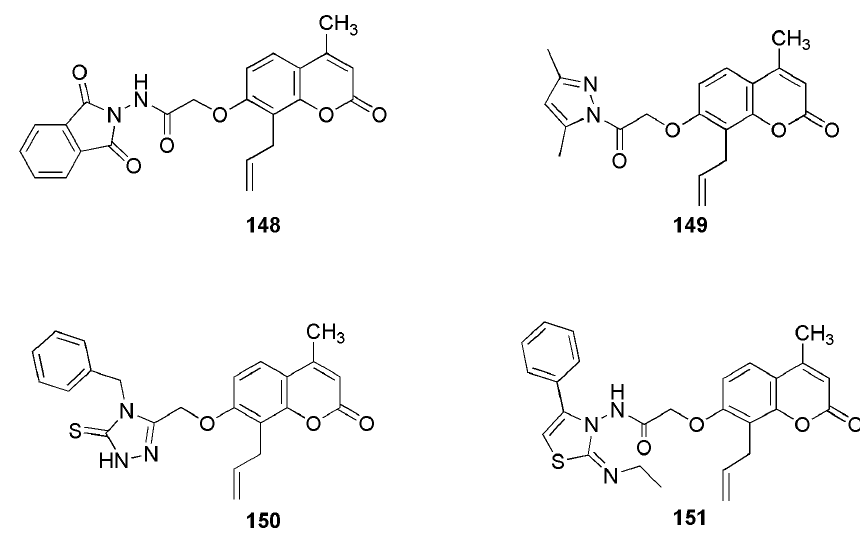
Figure 46. Chemical structure of compounds 148–151 .